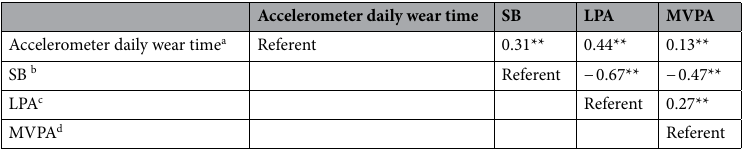
Table 2. Bivariate correlation coefficients between accelerometer daily wear time, SB, LPA, and MVPA. ** p < 0.001. a The sum of SB, LPA and MVPA. b Sedentary behaviour. c Light-intensity physical activity. d Moderate-to-vigorous physical activity.